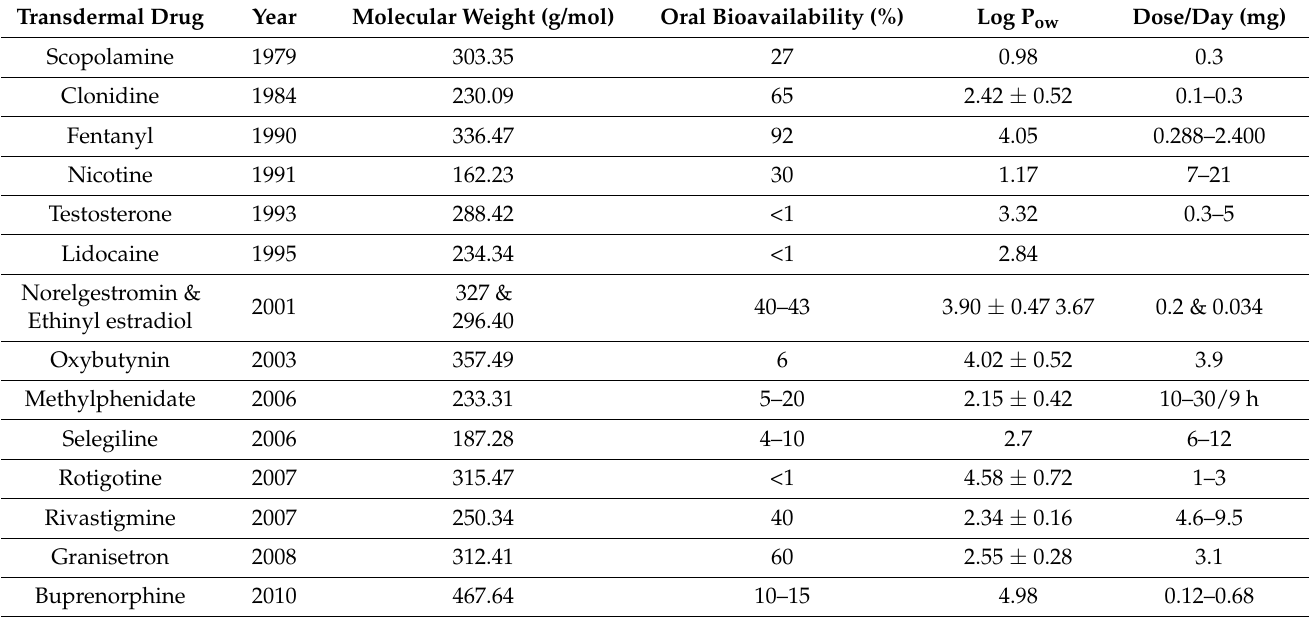
Table 1. Marketed transdermal formulations and associated properties